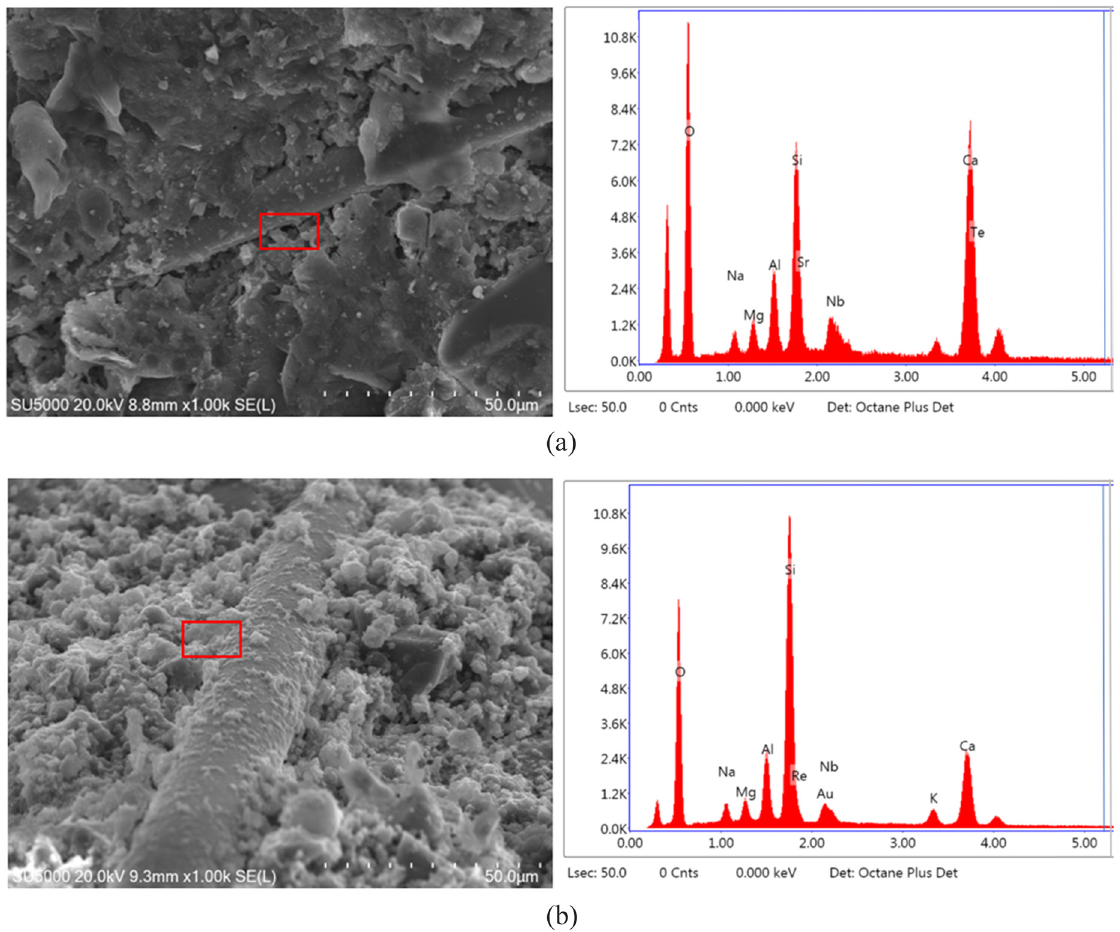
Figure 27: SEM - EDS analysis of BF - reinforced RAC containing NS - modi fi ed RA. ( a ) NS0BF12 - 2, ( b ) NS2BF12 -